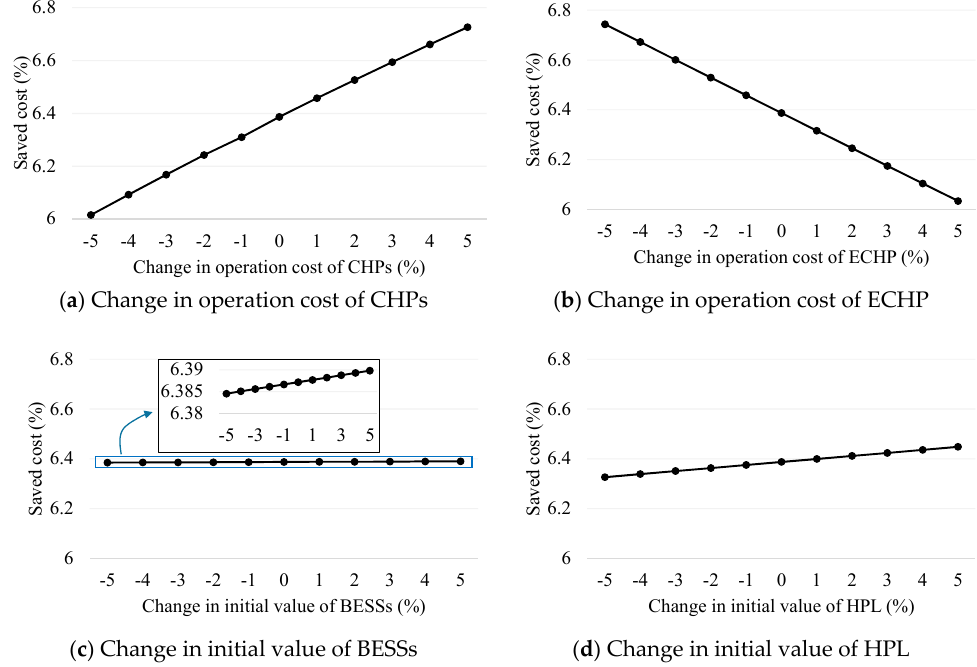
Figure 13. Sensitivity analysis of different values of parameters on saved cost during a weekday.